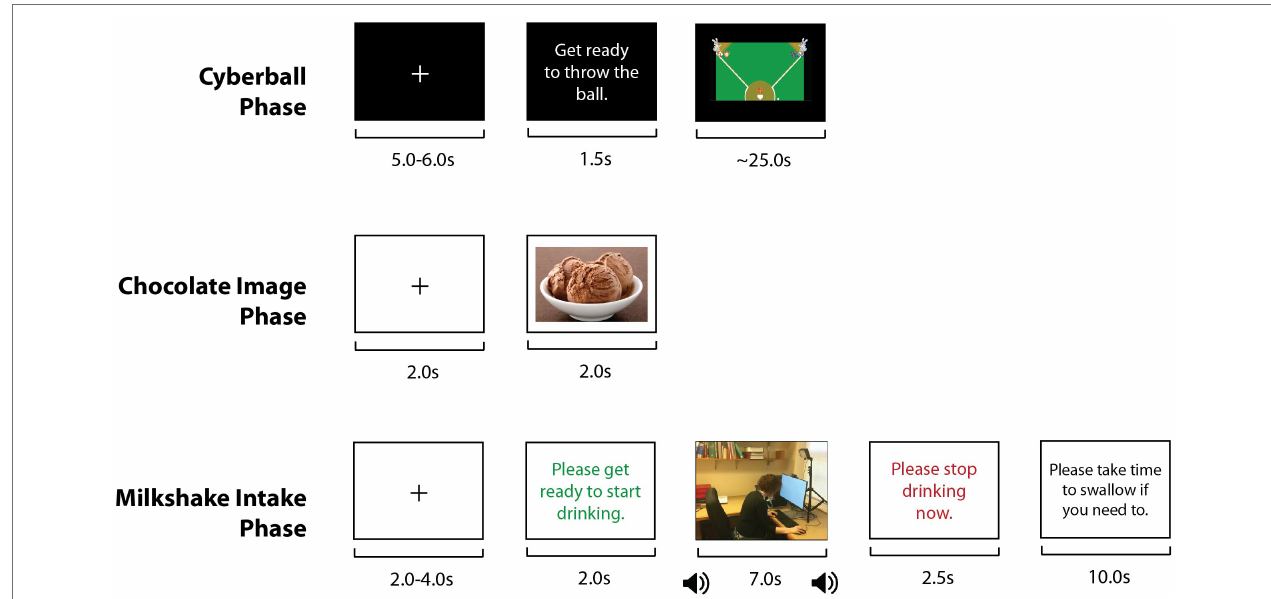
FIGURE 1 | Depiction of one trial of the Cyberball-Milkshake Task. The figure illustrates the three phases of each trial. The task included 12 trials, 6 inclusion, and 6 exclusion, depending on whether the fictitious “other players” included or excluded, respectively, the participant during the Cyberball phase of the